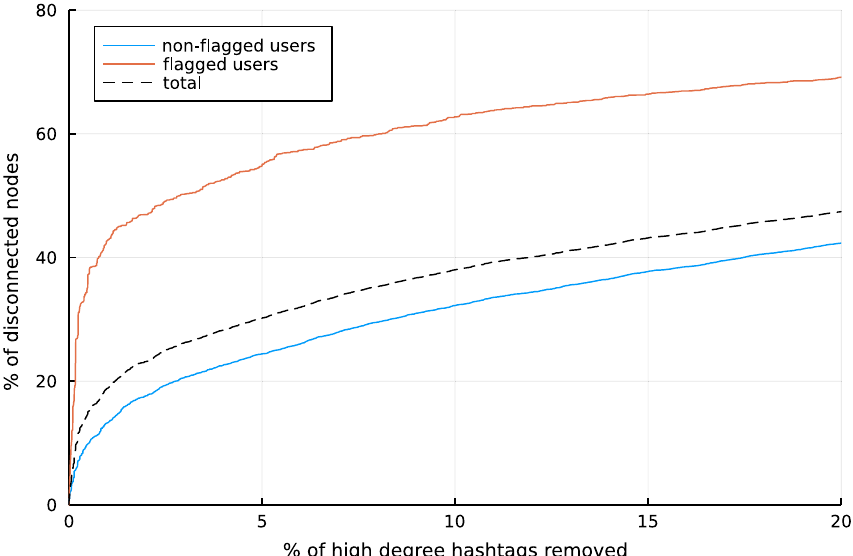
Fig. 8 Impact of hashtag removal on disconnected users in the Honduras user-hashtag bipartite